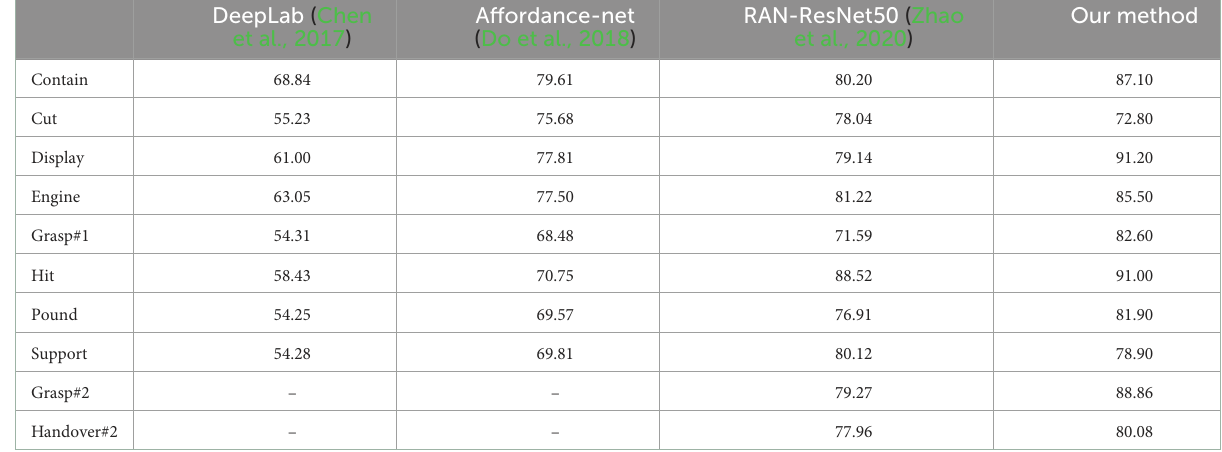
TABLE 1 Performance on IIT-AFF